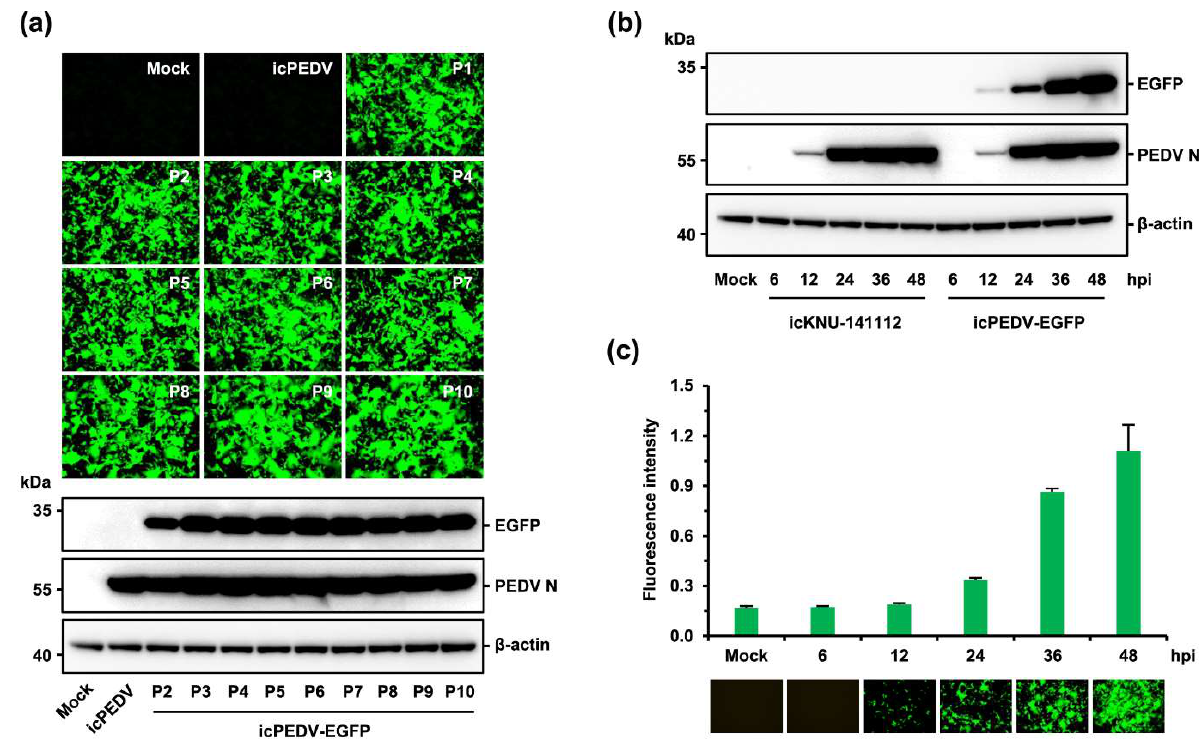
Figure 5. Genetic stability and retention of the EGFP gene of icPEDV-EGFP. ( a ) EGFP expression of icPEDV-EGFP during serial passages. Vero cells were mock-infected or infected with icKNU-141112 (icPEDV) and 100-fold diluted icPEDV-EGFP harvested at the indicated passage history (P1–P10) and observed at 48 hpi with a fluorescence microscope at a magnification of 100× (upper panels). Whole-cell lysates were prepared promptly after fluorescence microscopy and subjected to Western blotting with an antibody specific for EGFP or PEDV N. The blot was also reacted with mouse MAb against β-actin to confirm equal protein loading (bottom panel). ( b ) EGFP expression kinetics of icPEDV-EGFP. Vero cells were mock infected or infected with icKNU-141112 and icPEDV-EGFP at an MOI of 0.1. Cell lysates were prepared at the indicated time points and subjected to immunoblotting of an antibody against EGFP (top panel), PEDV N (second panel), or β -actin (bottom panel). ( c ) Fluorescence intensity kinetics of icPEDV-EGFP. Vero cells were mock infected or infected with icPEDV-EGFP at an MOI of 0.1. At the indicated time points, the EGFP fluorescence emission was detected by fluorometry, and the kinetics data were plotted. Green fluorescence images acquired with a fluorescence microscope at a magnification of 100× are presented at the bottom. The values shown are the mean of three independent experiments, and the error bars denote the SDM.